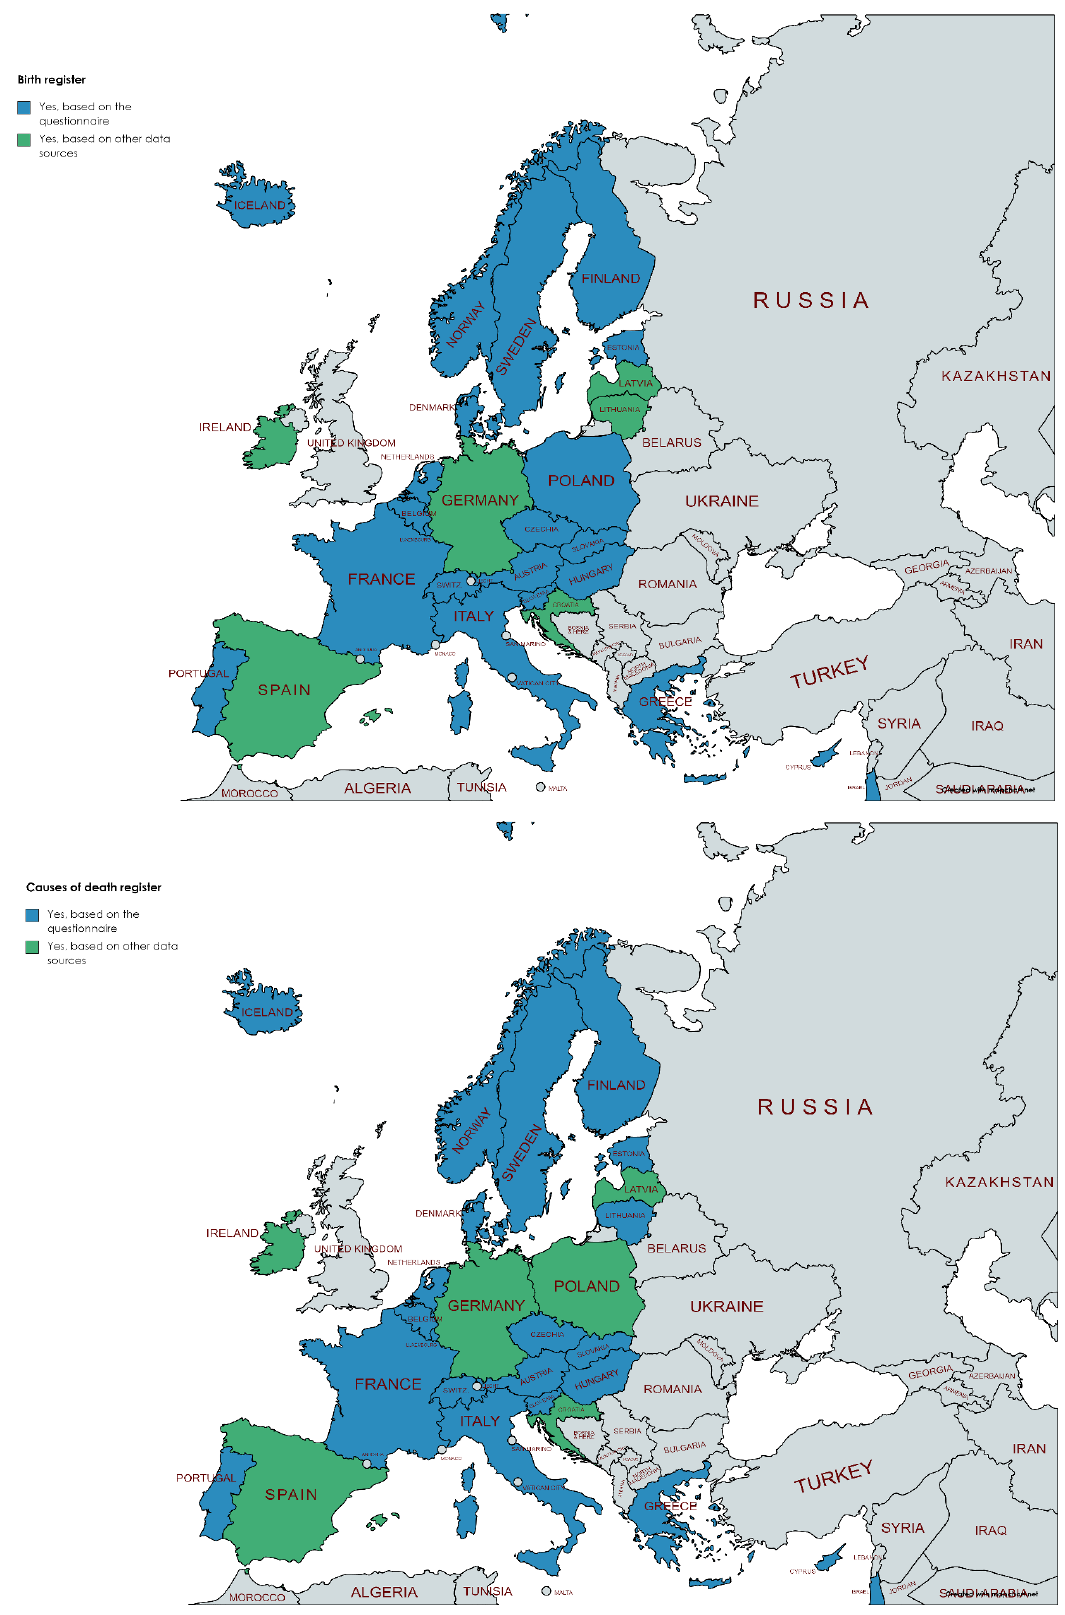
Figure 2. Availability of civil registers for births and deaths (blue = provided by the National Hub contact points, green = obtained from other data sources as described in the Section 2). Figure has been created using MapChart.net web tool.